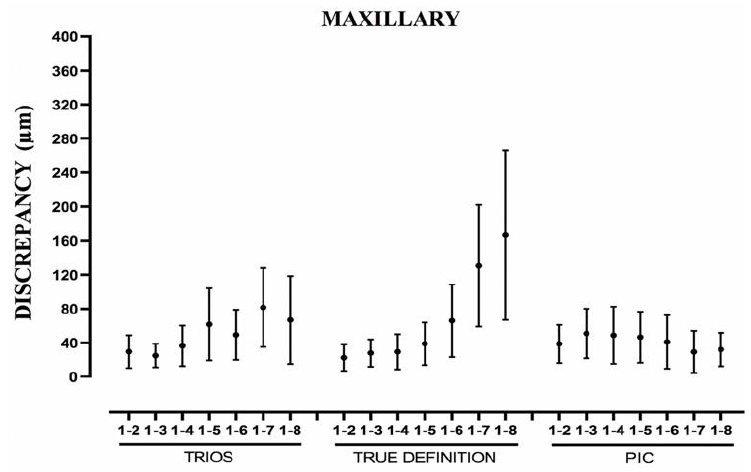
Figure 4. Boxplot showing measurements of Euclidean distances from distance 1-2 to 1-8 of maxillary arch. Point represents mean error; line represents standard deviation.